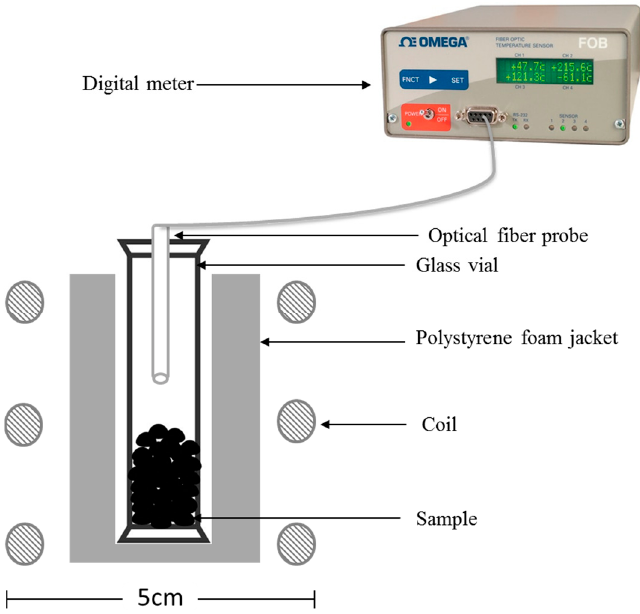
Figure 1. Exposure setup AMF using the induction heater. The optical fiber thermometer, sample holder, polystyrene foam jacket and coil dimensions are shown.